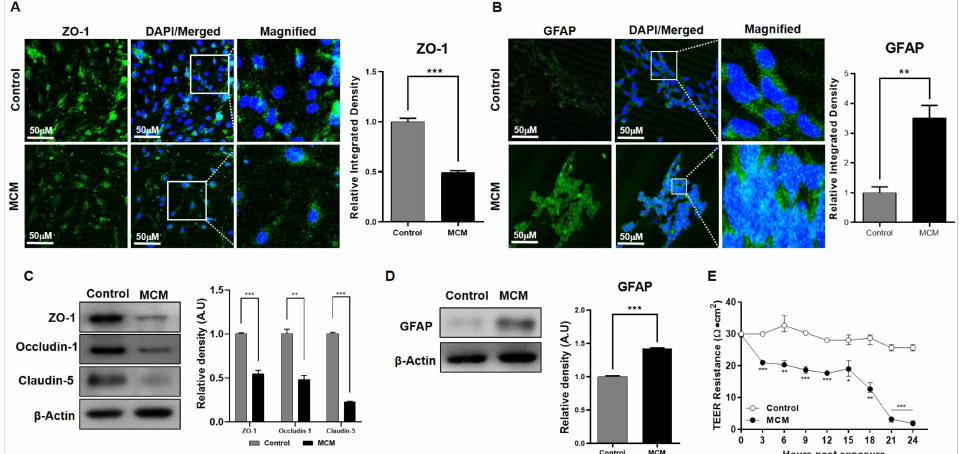
Figure 5. The effect of the pro-inflammatory response on the BBB. ( A ) Immunofluorescence staining was used to estimate the expression level of ZO-1 in bEnd.3 cells between the control and bEnd.3 cells exposed to activated microglial conditioned media (MCM). ( B ) Confocal microscopic images of C8-D1A cells compare glial fibrillary acidic protein (GFAP) expression in the control group as well as in the MCM-treated group. ( C ) Immunoblots show the protein expression of ZO-1, occuludin-1, and claudin-5 in bEnd.3 cells harvested from the control and MCM-exposed cells ( D ). Western blot comparison of GFAP protein expression in C8-D1A cells harvested from the control and MCM- exposed cells. ( E ) Comparison of TEER resistance values compared across the transwell membrane of the control and MCM-treated group. All data had a sample size of three ( n = 3) and three experimental repeats. Data are presented as mean ± SEM. p < 0.05 was considered to be statistically significant. * p < 0.05, ** p ≤ 0.01 and *** p ≤